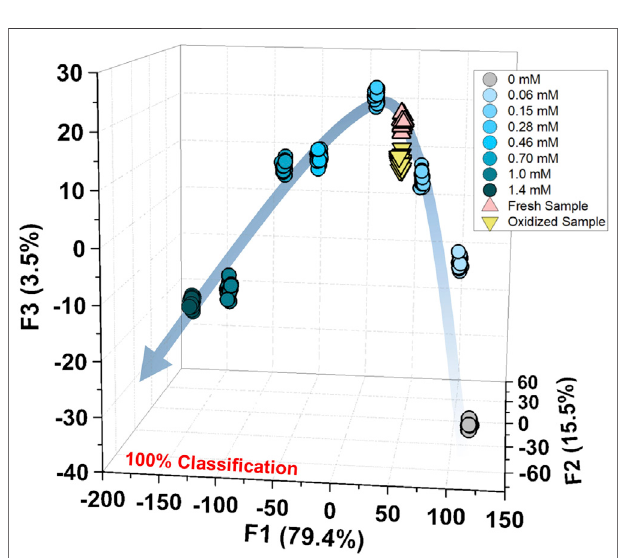
FIGURE 6 | Semiquantitative analysis for the fresh and oxidized tomato samples with the calibration of GSH (0 – 1.4 mM). The measurements were repeated twenty times, resulting in 100% accurate classi fi cation.